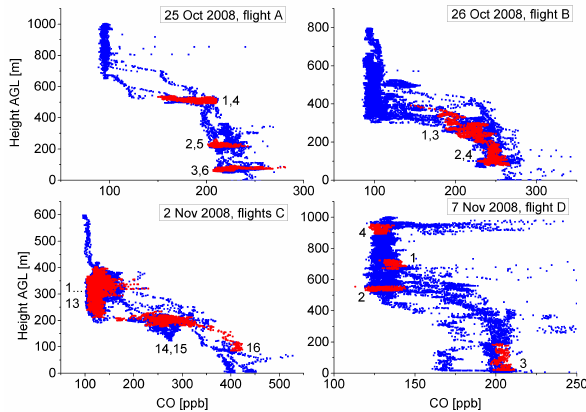
Fig. 11. Vertical profiles of CO mixing ratios, visualising the height of the PBL; the time resolution is 1 s . Data points from time periods during which canisters were filled, are marked in red. The canisters are numbered in chronological order.